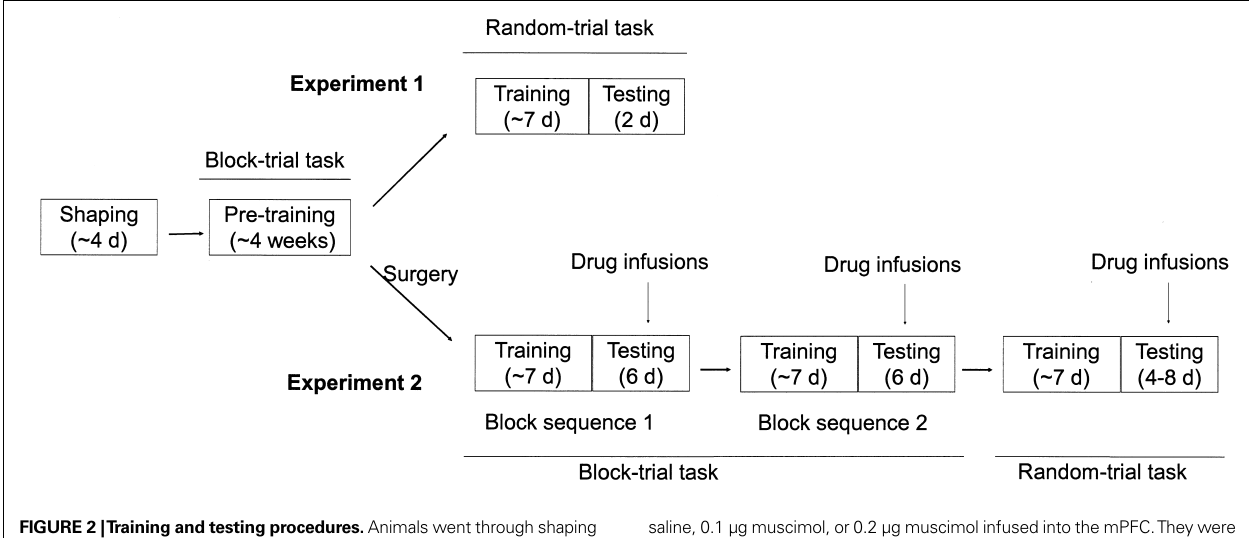
FIGURE 2 | Training and testing procedures. Animals went through shaping ( ∼ 4 days) and pre-training ( ∼ 4 weeks) in the block-trial task. One group of animals was further trained to perform the random-trial task ( ∼ 7 days) and their performance was tested (experiment 1). The other group of animals was subject to surgery, re-trained in the block-trial task, and tested in the same task with